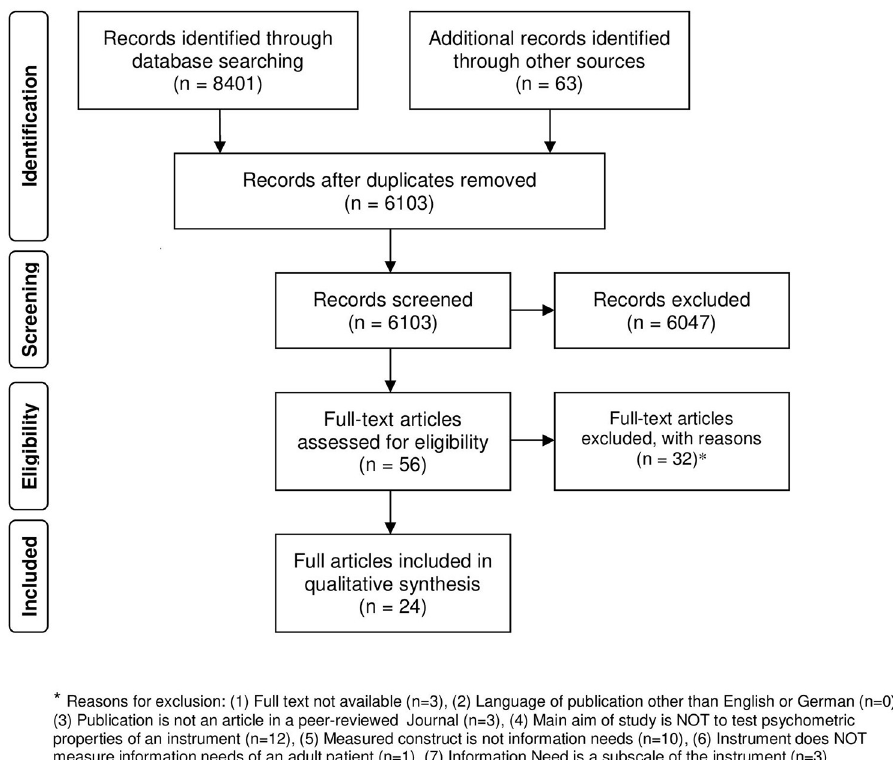
Fig 1. Flow diagram of study